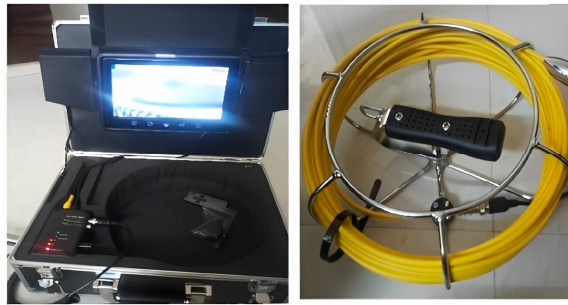
Figure 4. Watertight sewer camera. Table 1. Specifications of a utilized sewer